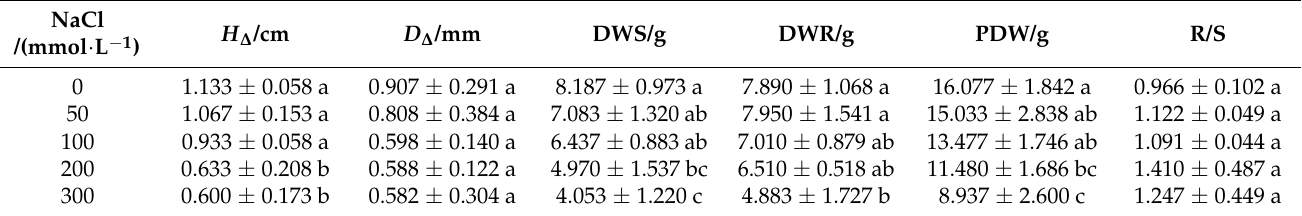
Table 3. Growth indexes of the seedlings of J. microcarpa L. under salt stress. The data are presented as treatment mean ± SD. Different English letters in the same column indicate a significant difference at the level of